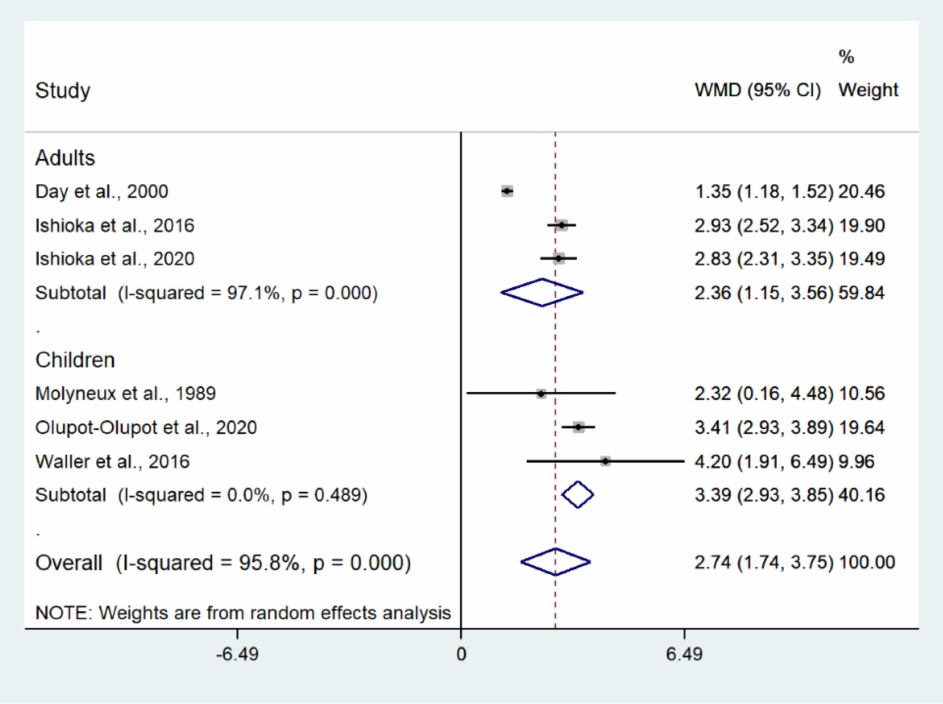
Figure 10. Lactate levels in patients with severe malaria who died and those who survived. Abbrevi- ations: WMD, weighted mean difference; CI, confidence